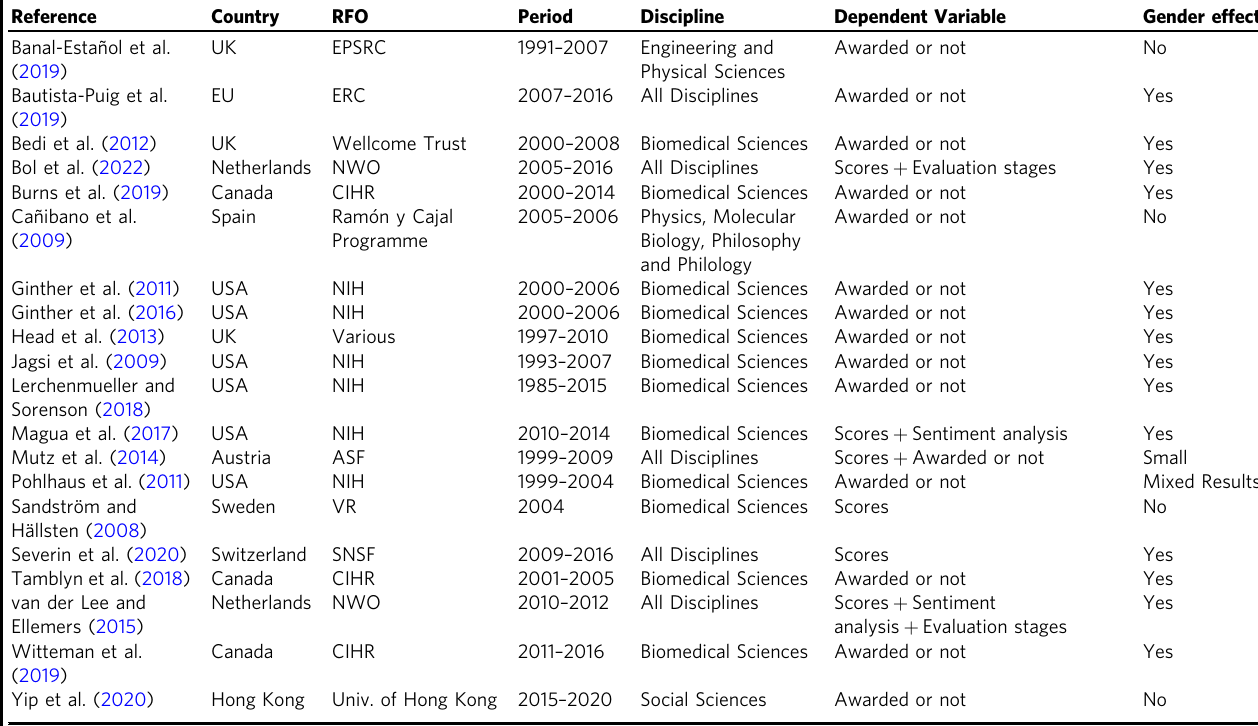
Table 1 Previous empirical studies on gender bias in grant